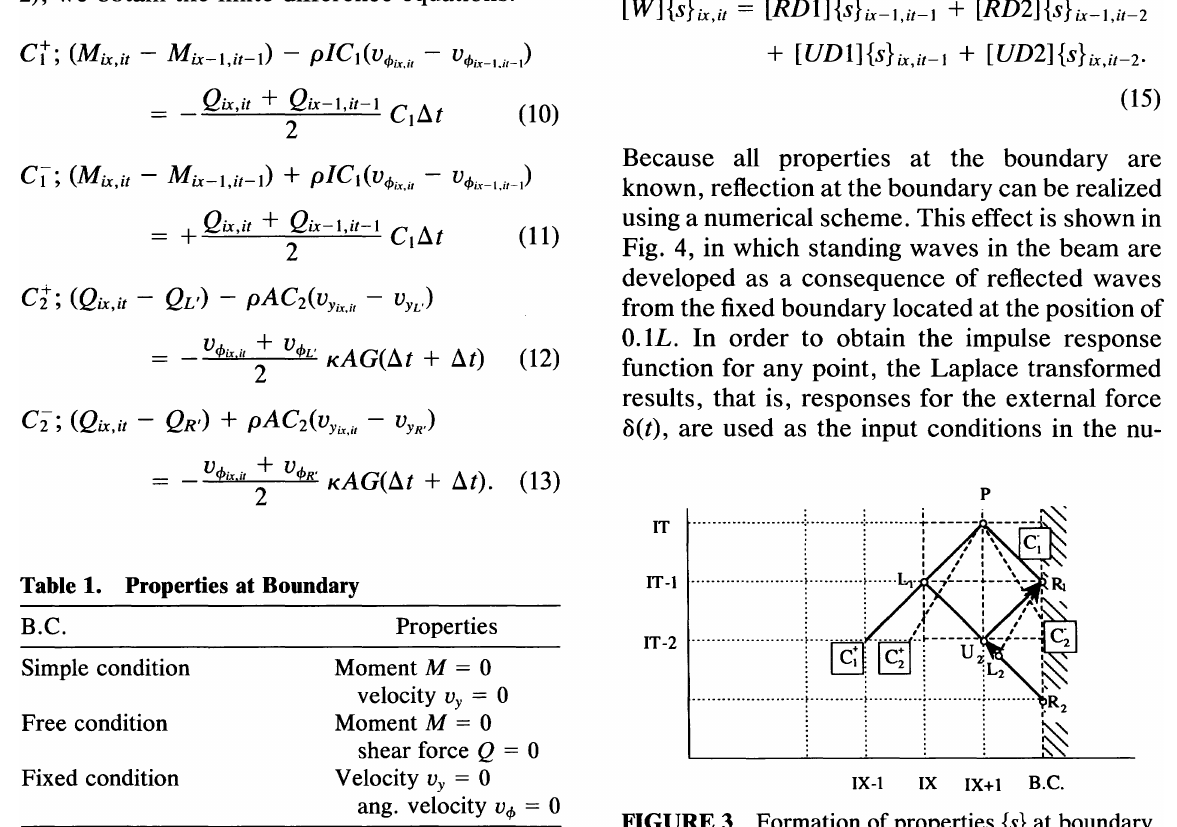
FIGURE 3 Formation of properties {s} at